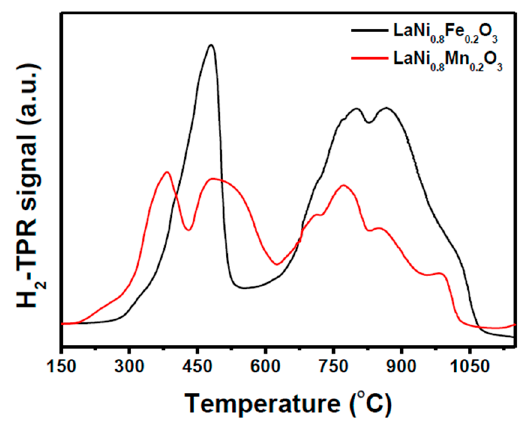
Figure 2. Temperature programmed reduction of LaNi 0.8 Fe 0.2 O 3 and LaNi 0.8 Mn 0.2 O 3 perovskites performed under 5% H 2 atmosphere.